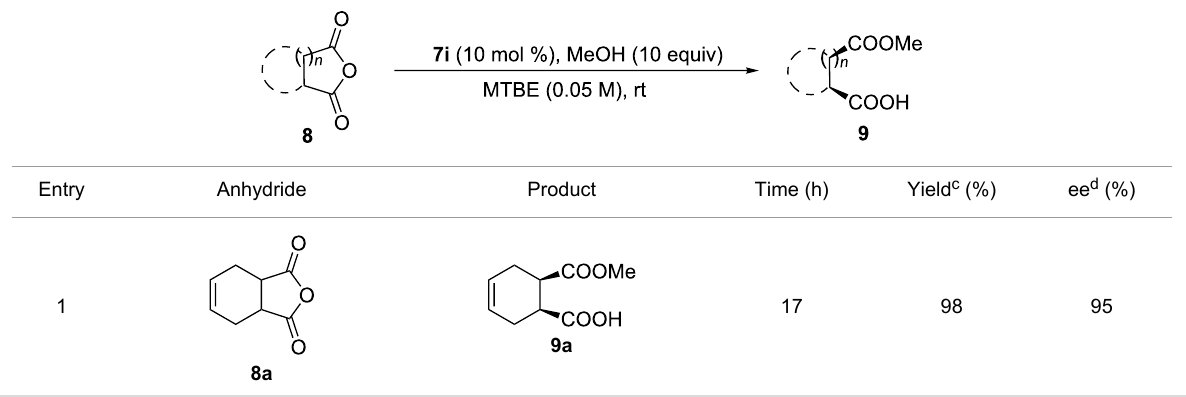
Table 2: Asymmetric methanolysis of meso -cyclic anhydrides. a,b .